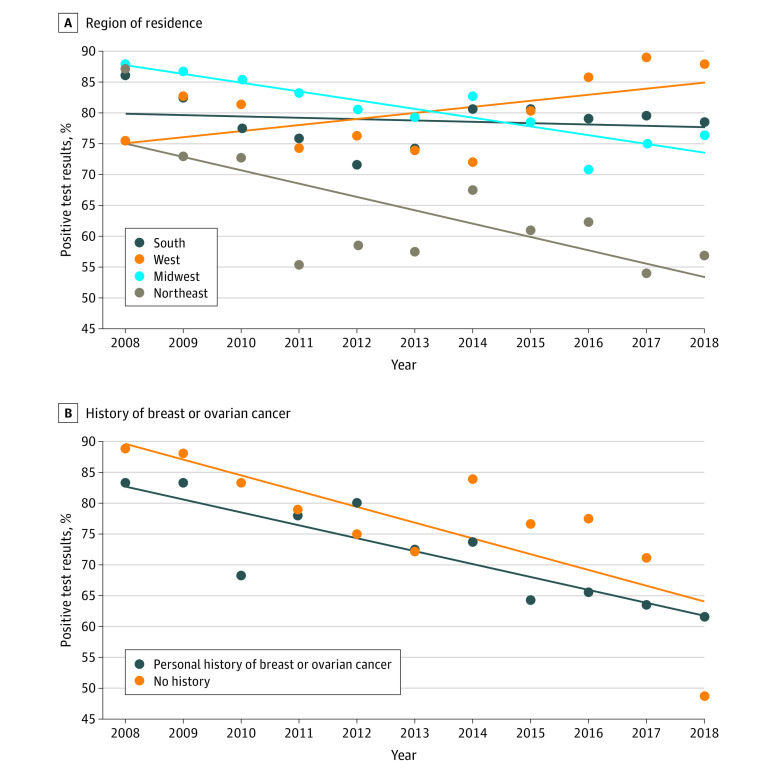
Documented Positive BRCA Test Results by Region of Residence and Personal History of Breast or Ovarian Cancer, 2008-2018A, Region of residence. B, Personal history of breast or ovarian cancer. The diagonal lines indicate the trend in documented positive BRCA test results.